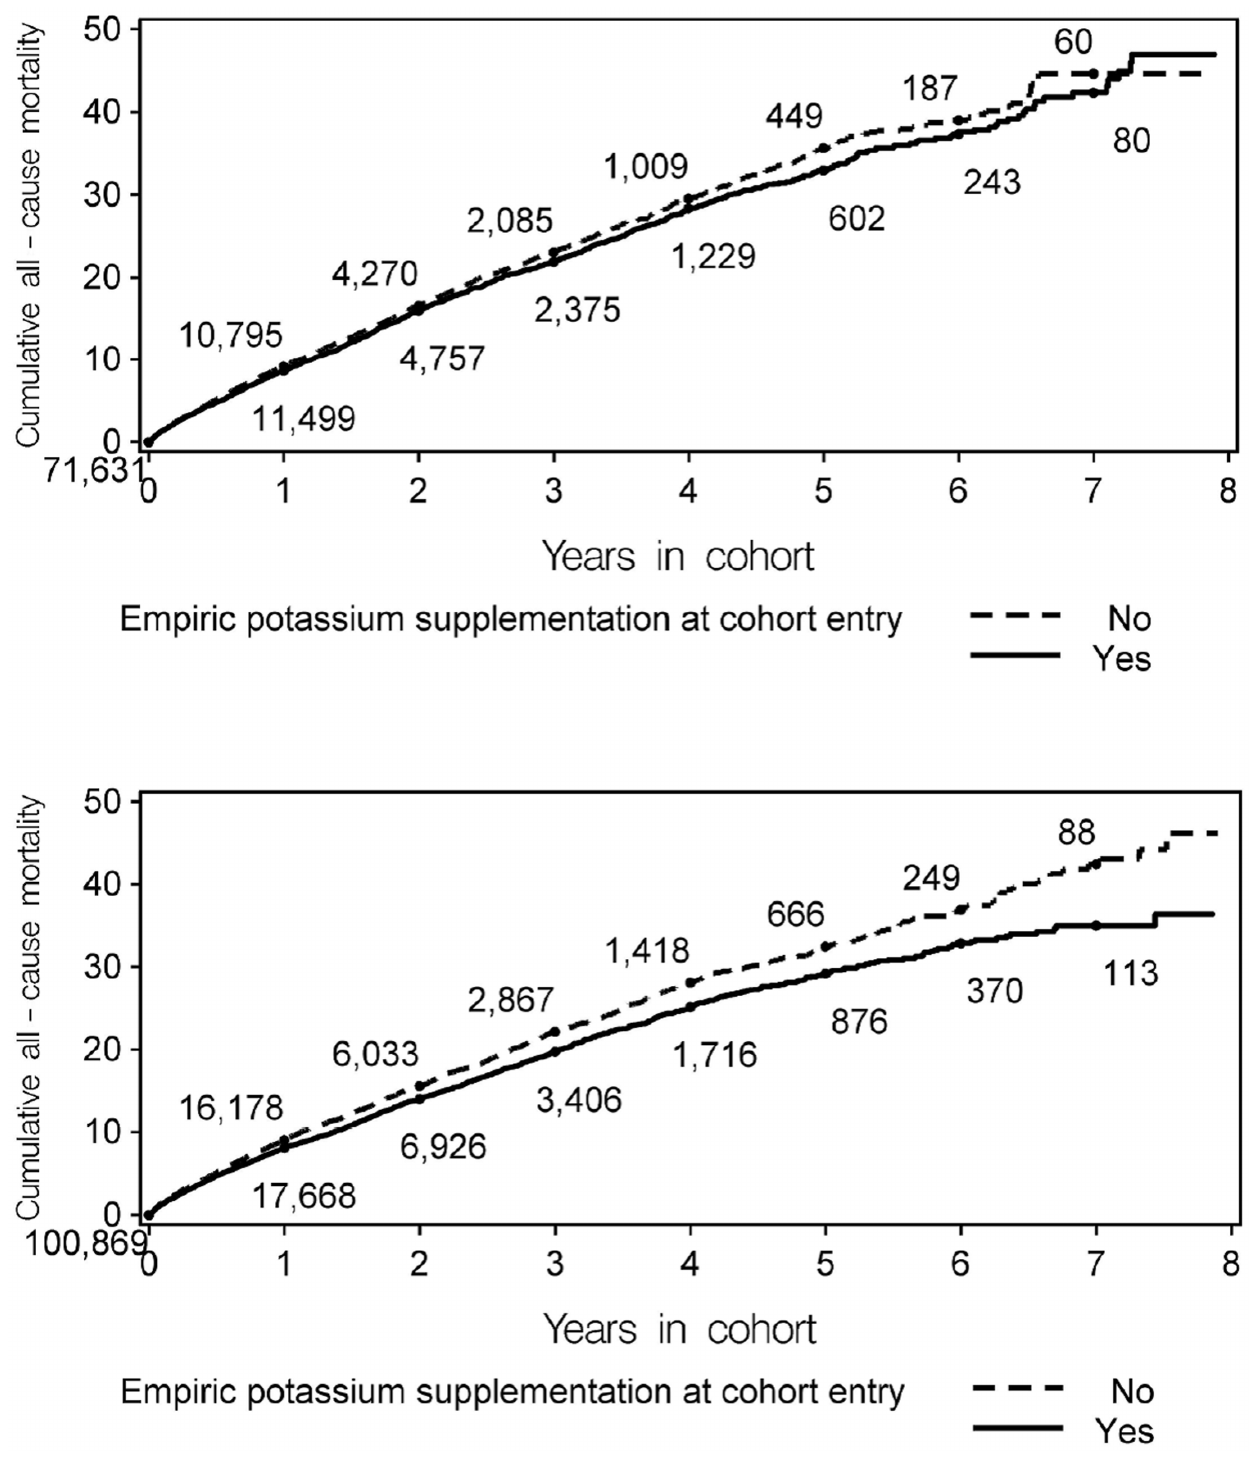
Figure 1. Time-to-death curves for empiric potassium supplementation among furosemide initiators, stratified by initial furosemide dose. Figure 1a. Initial furosemide dose , 40 mg/day (N=71,631 in each of the empiric potassium exposed and unexposed groups). Figure 1b. Initial furosemide dose $ 40 mg/day (N=100,869 in each of the empiric potassium exposed and unexposed groups).